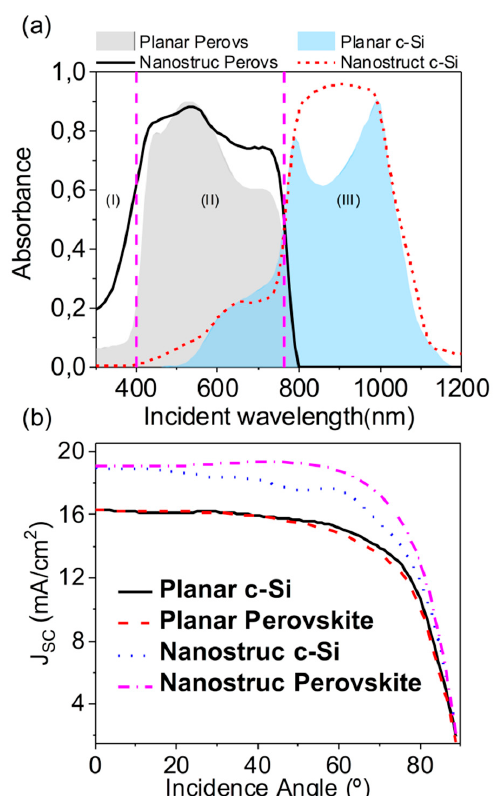
Figure 4. ( a ) Comparison of the spectral evolution of the absorbance in each subcell between a typical monolithic tandem solar cell with a planar perovskite (gray area) and crystalline silicon (blue area) layers and that of the proposed optimum structure with a nanostructured perovskite (black solid line) and c-Si (red dashed line) layers along the solar spectrum. TE polarization is considered. Vertical dashed lines delimit three interesting spectral regions (see explanation in the discussion). ( b ) Short-circuit current density generated in each subcell of a planar device (c-Si subcell, solid black line; perovskite subcell, dashed red line) and the proposed device (c-Si subcell, dotted blue line; perovskite subcell, dash-dotted pink line) as a function of incidence angle of the incoming light.